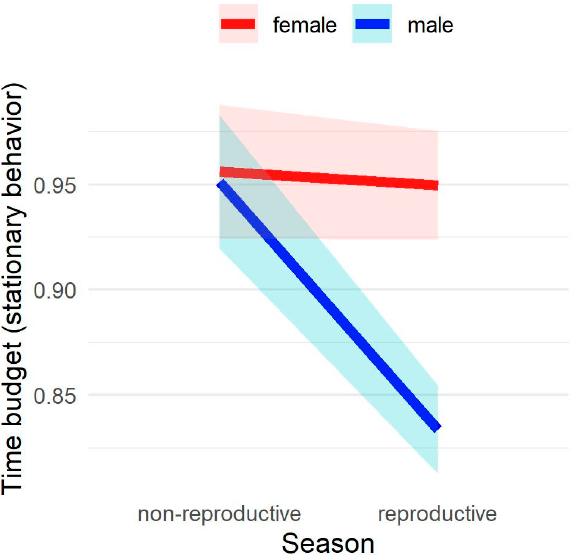
Figure 6. Relationship between season (reproductive vs. non-reproductive) and the proportion of time (time budget) spent performing stationary behavior by males and females of Anolis homolechis . Colored ribbons represent 95% confidence intervals.